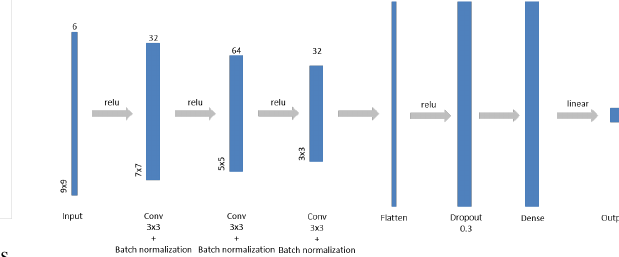
Figure 10. Final CNN architecture for